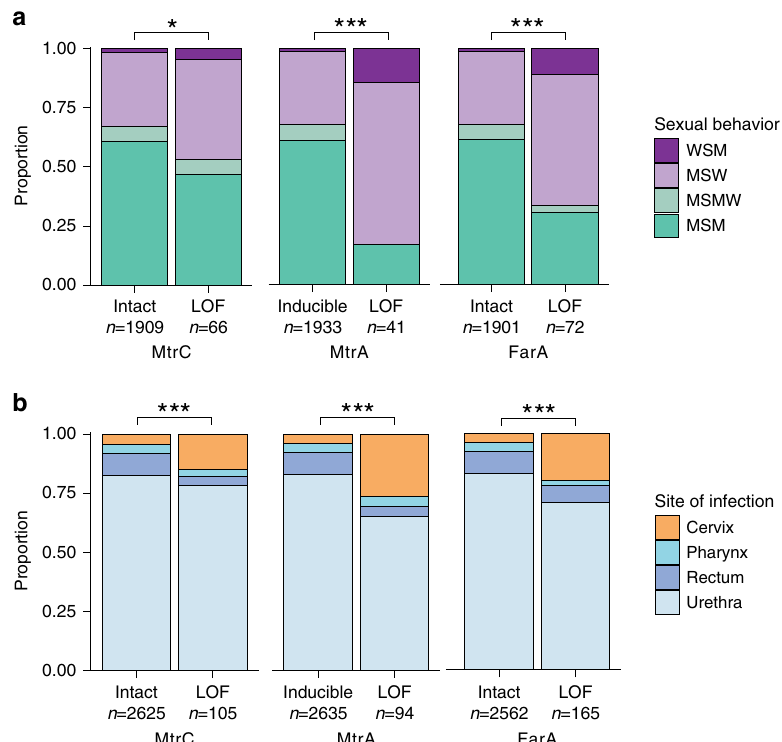
Fig. 3 Gonococcal mtrC , mtrA , and farA LOF mutations are associated with cervical infection. a Sexual behavior of patients infected with isolates with either intact or LOF alleles of mtrC (left), mtrA (middle), or farA (right). b Site of infection in patients infected with isolates with either intact or LOF alleles of mtrC (left), mtrA (middle), or farA (right). mtrA alleles were predicted as LOF only in the absence of other epistatic Mtr overexpression mutations. Statistical signi fi cance between genotype and patient metadata was assessed by two-sided Fisher ’ s exact test: * p < 0.05, ** p < 0.01, and *** p < 0.001. Exact p- values from left to right for analyses in a were 0.04021, 1.81 × 10 − 11 , 5.06× 10 − 10 and for b were 6.49 × 10 − 5 , 1.64 × 10 − 12 , 1.78 × 10 − 12 . WSM = women who have sex with men, MSW = men who have sex with women, MSMW = men who have sex with men and women, MSM = men who have sex with